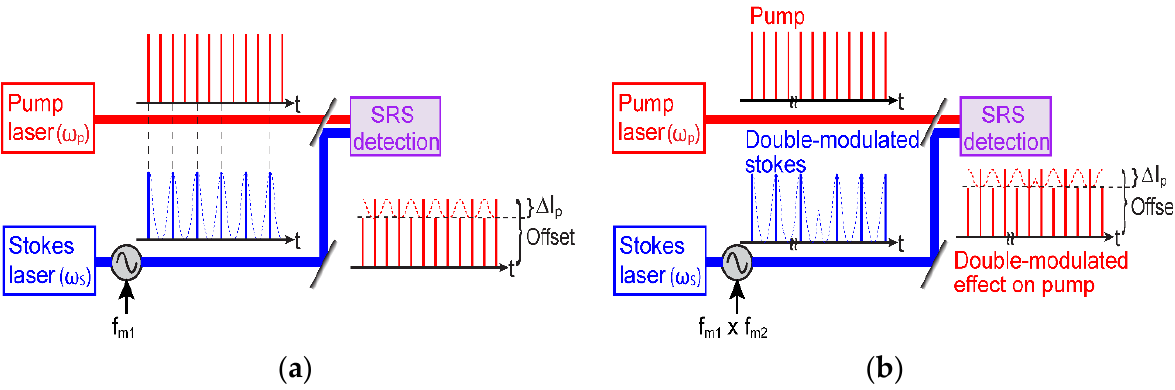
Figure 1. Principle of lock-in SRS signal detection: ( a ) Single-modulation and ( b ) Double-modulation.